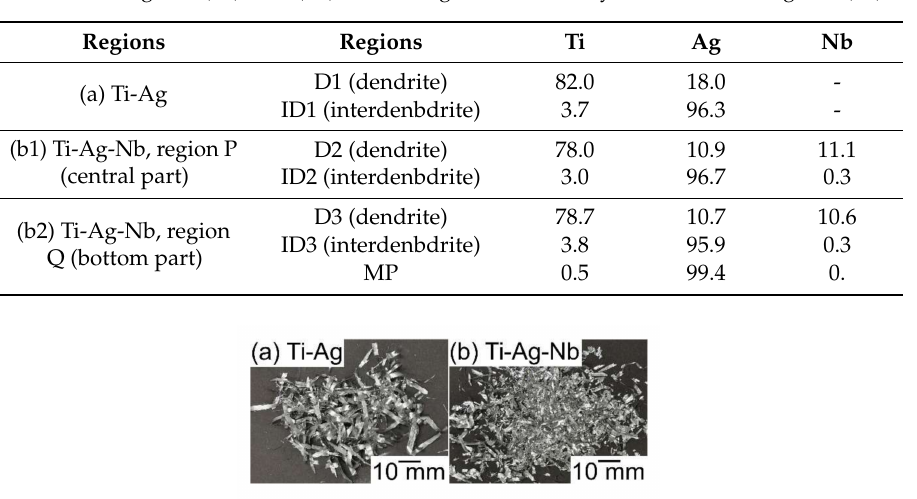
Figure 7. Outer appearances of the rapidly-solidified melt-spun ribbons in the Ti 66.7 Ag 33.3 ( a ) and Ti 53.4 Ag 33.3 Nb 13.3 ( b ) alloys.